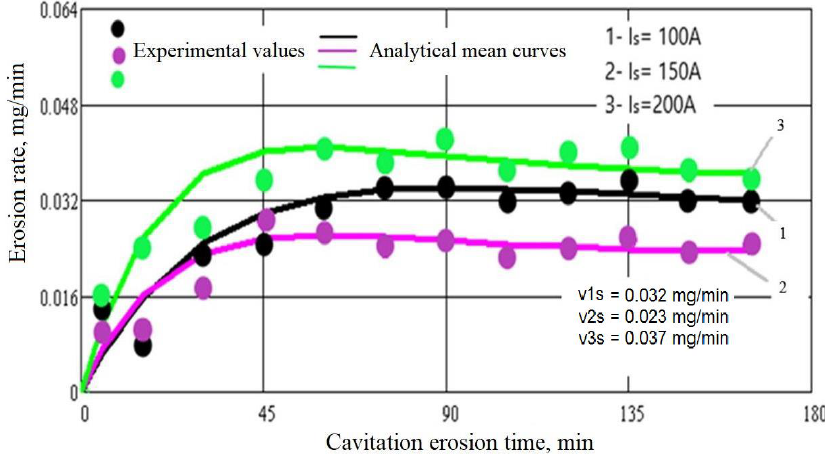
Figure 5. Erosion rate of GX40CrNiSi25-20 steel at different remelting current intensities.